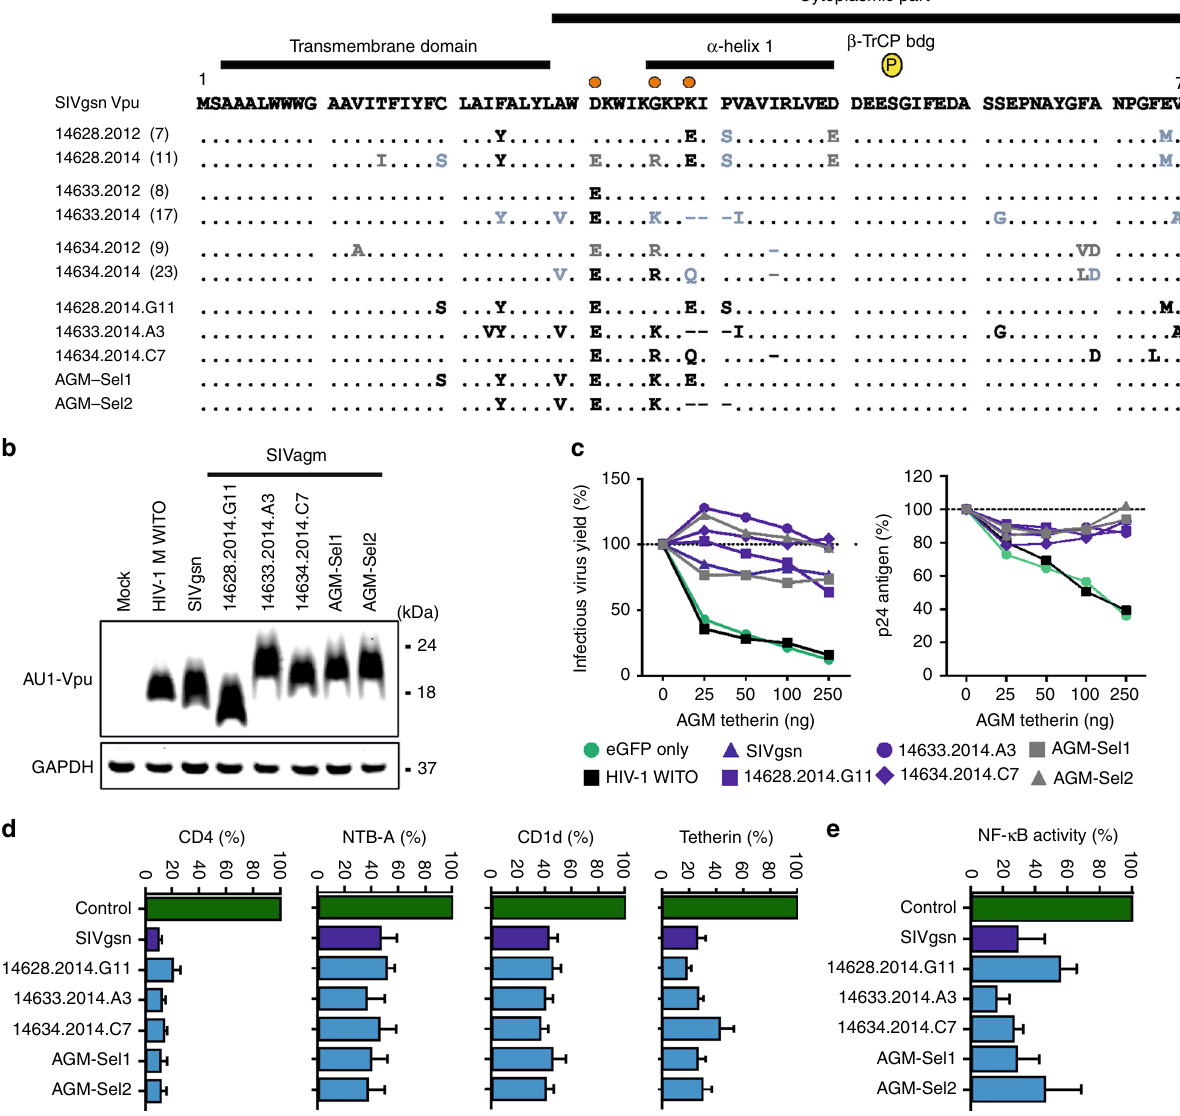
Several Nef alleles obtained from WT SIVagm infected animals contained changes of G93R, V98A/T and T153/P/E/V (Supple- mentary Fig. 5a) and displayed increased activity in down- modulating MHC-I compared to the parental SIVagm Nef protein (Fig. 5c). HIV-1 Nef sequences obtained from several 1N or GU1N infected animals contained basic K residues in the acidic domain (EEEE) and/or changes of R8C/S/G and M20K/L. In two of three GU1N infected AGMs, the HIV-1 Nef became less potent in downmodulating CD28, whereas this was not the case